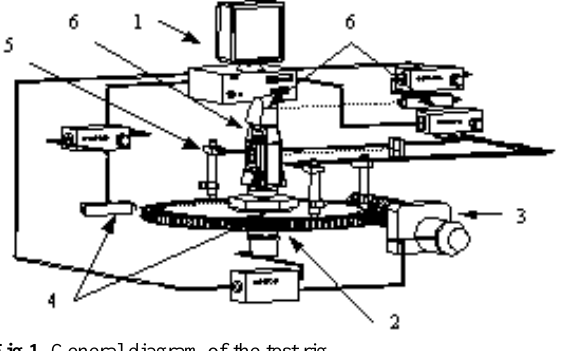
Fig 1 . General diagram of the test rig photoelectric autocollimator